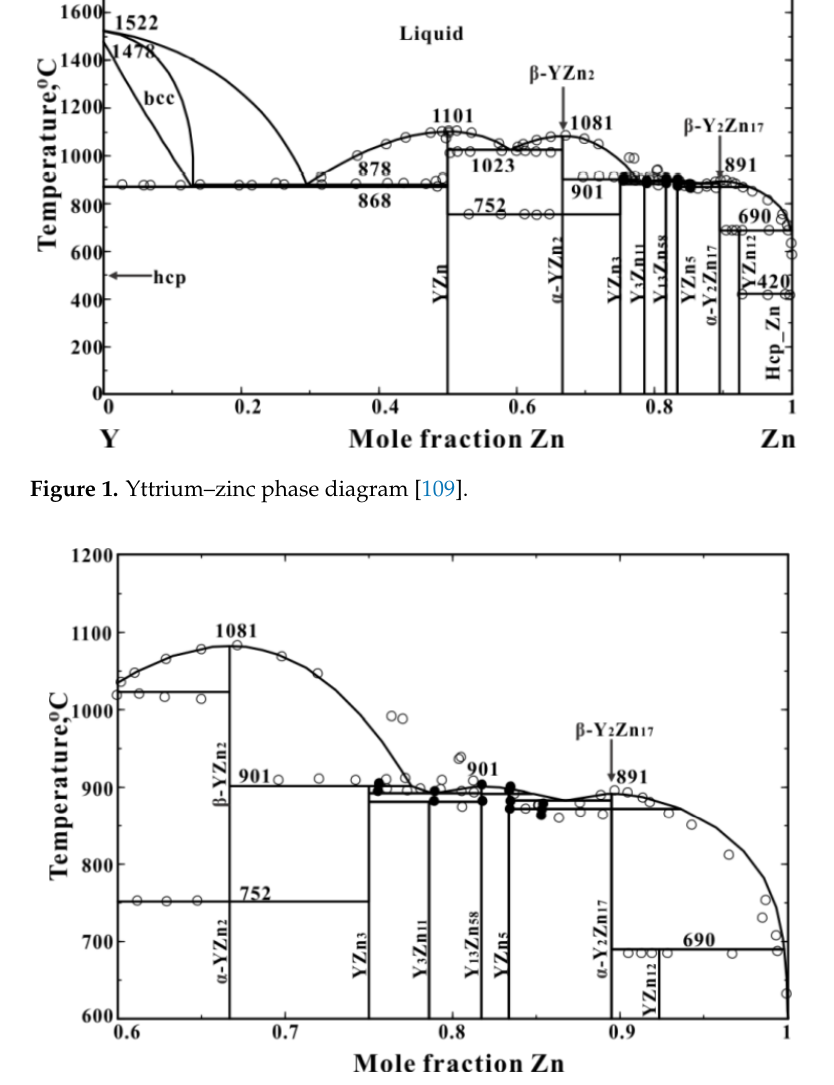
Figure 2. Yttrium–zinc phase diagram in Zn-rich region [109].